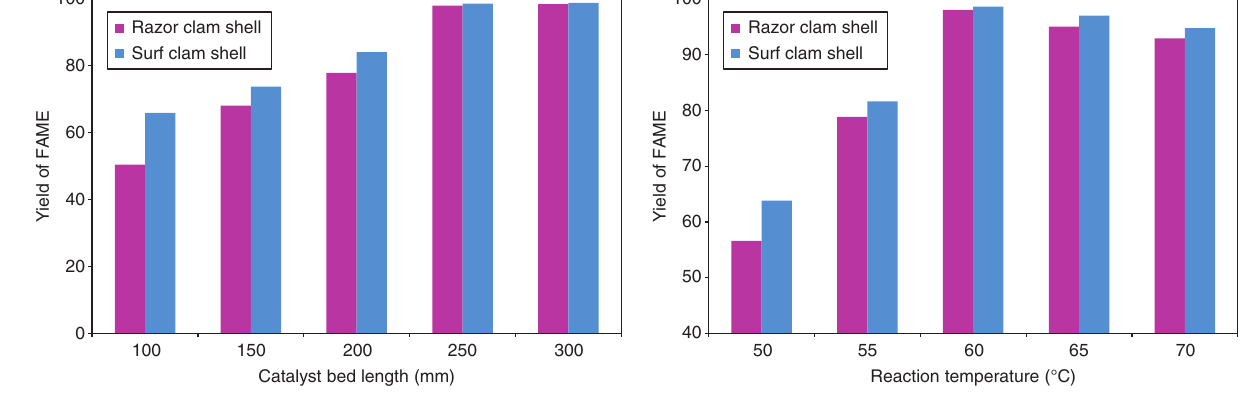
Figure 6: Effect of catalyst bed length on % yield of fatty acid methyl ester (FAME) (residence time 1.5 h, reaction temperature 60 ° C, and methanol/oil molar ratio 15:1).